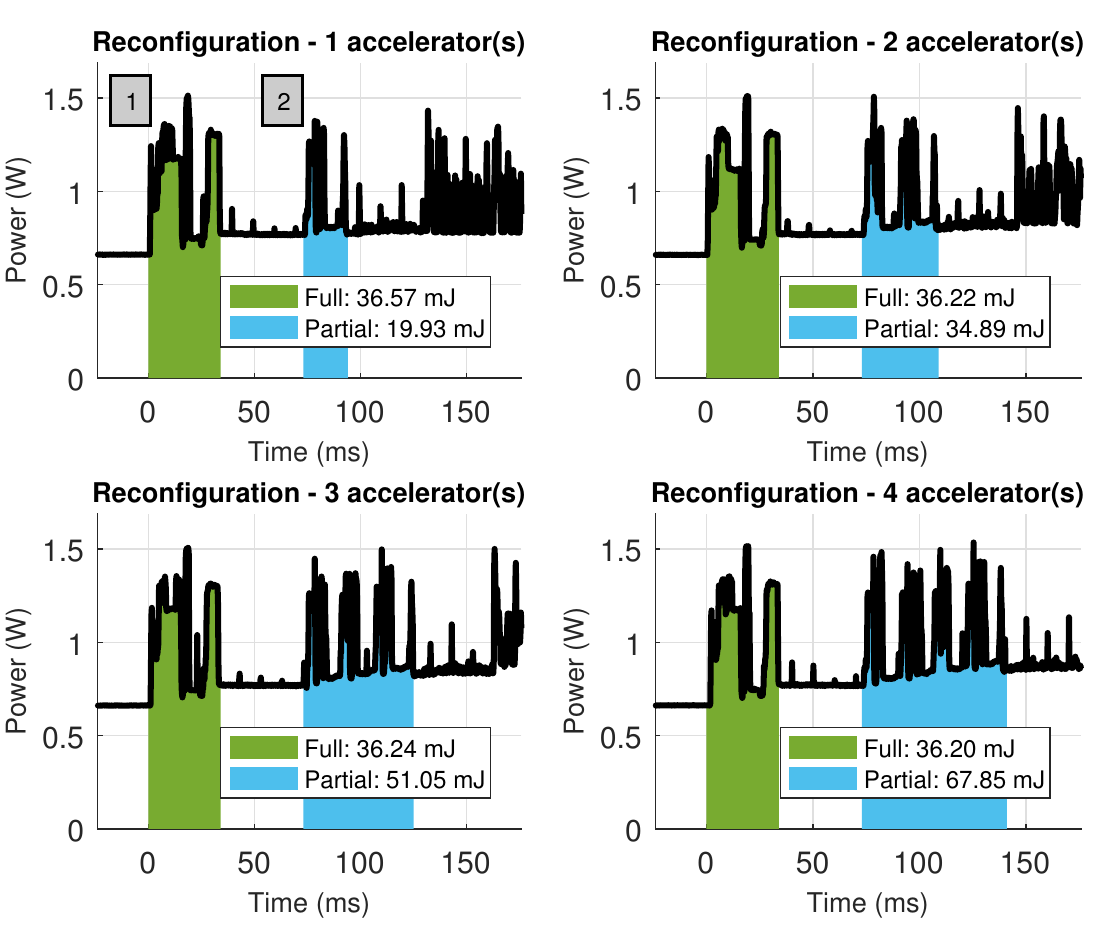
Figure 16. Energy consumption in the Zynq-based board during reconfiguration (either full or partial) when changing the number of accelerators.